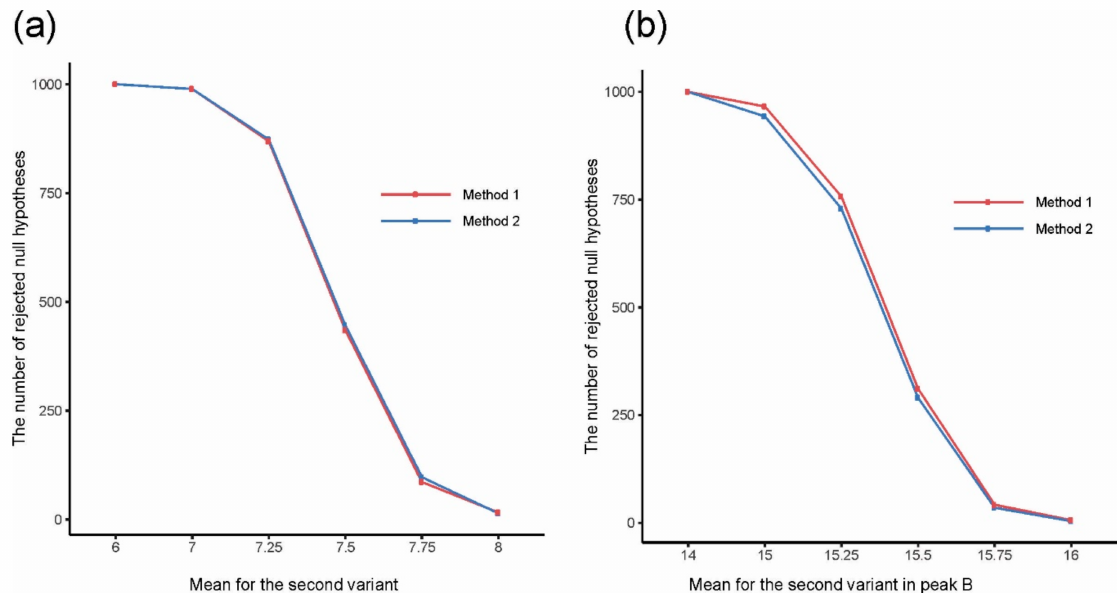
Figure 2. The number of rejected null hypotheses about equality of mean values for two experimental variants for ( a ) a single peak and ( b ) a double peak, depending on the mean value for the second variant in ( a ) a single peak and ( b ) peak